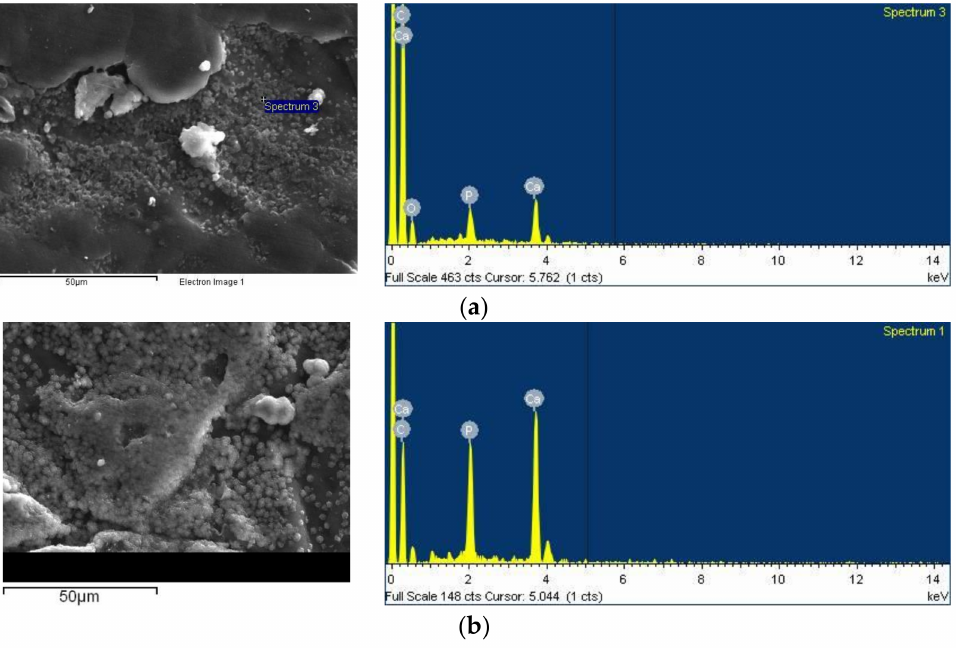
Figure 13. SEM micrographs and EDX spectra of ( a ) PCL/bBG 0.5% and ( b ) PCL/tBG 0.5% after 14 days of soaking in